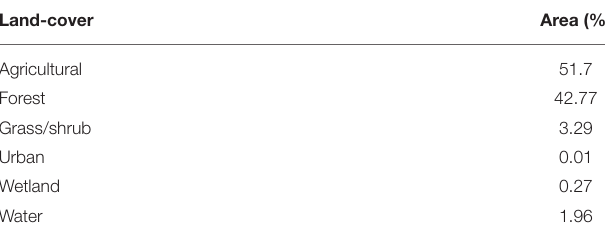
TABLE 2 | Land cover class distribution in the Narmada River